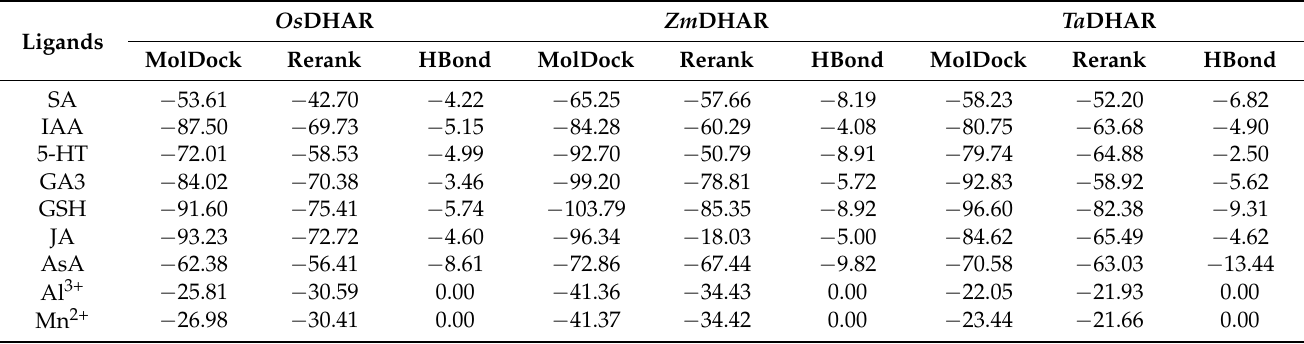
Table 2. Docking scores (MolDock, Rerank and Hydrogen bond) of DHAR of rice, maize and wheat with different ligands, including ions.